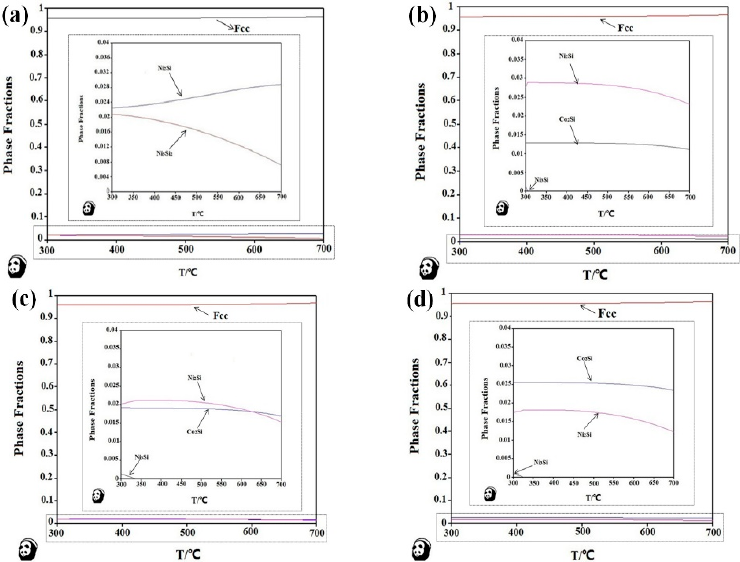
Figure 3. Relationship between the mass fraction of the equilibrium precipitation phase and the temperature of the test alloy ( a ) S1. ( b ) S2. ( c ) S3. ( d ) S4.